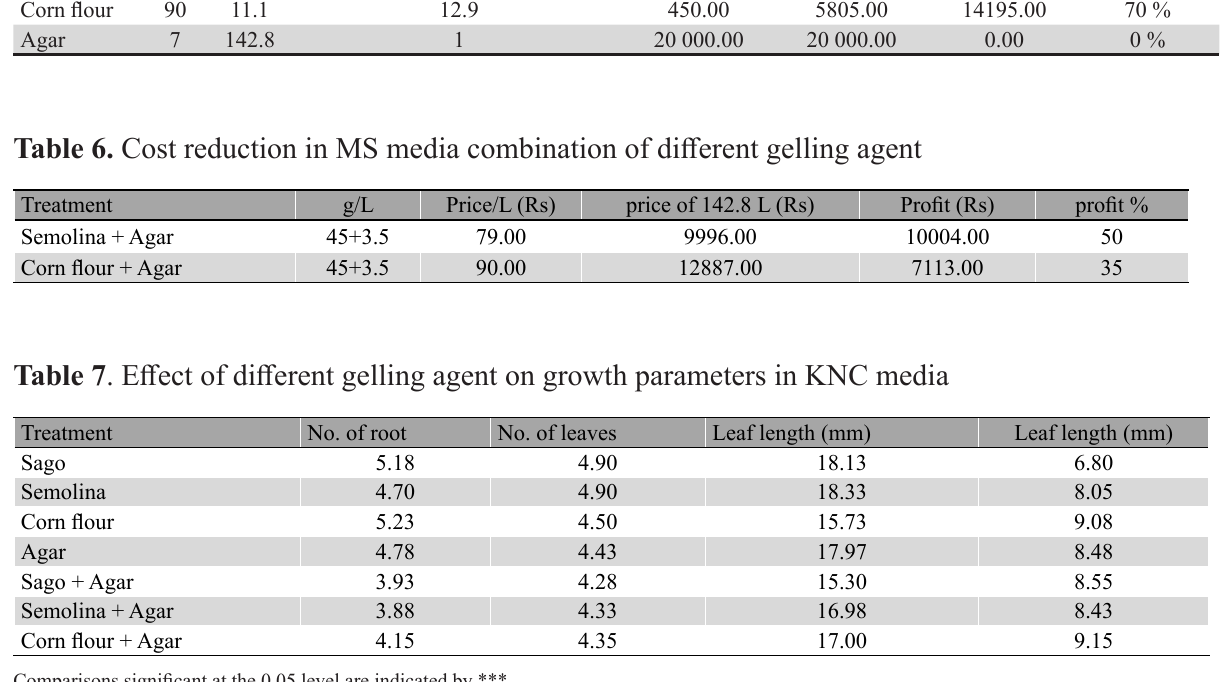
Corn flour + Agar Comparisons significant at the 0.05 level are indicated by